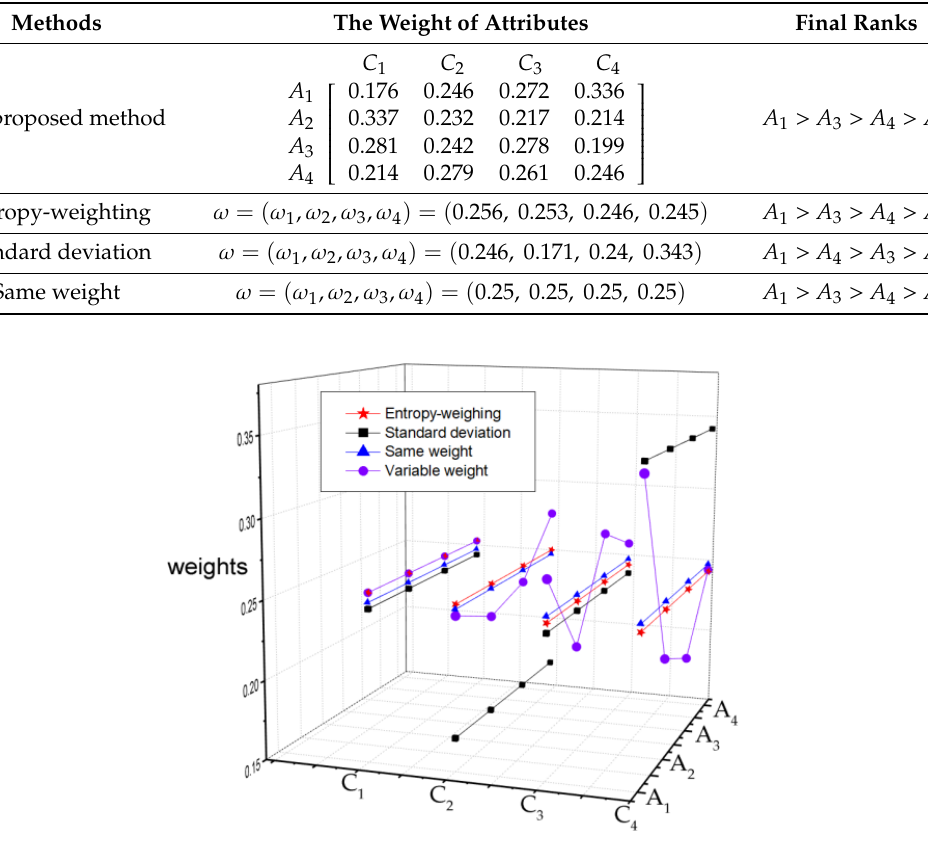
Table 8. The comparison of mentioned weight methods.